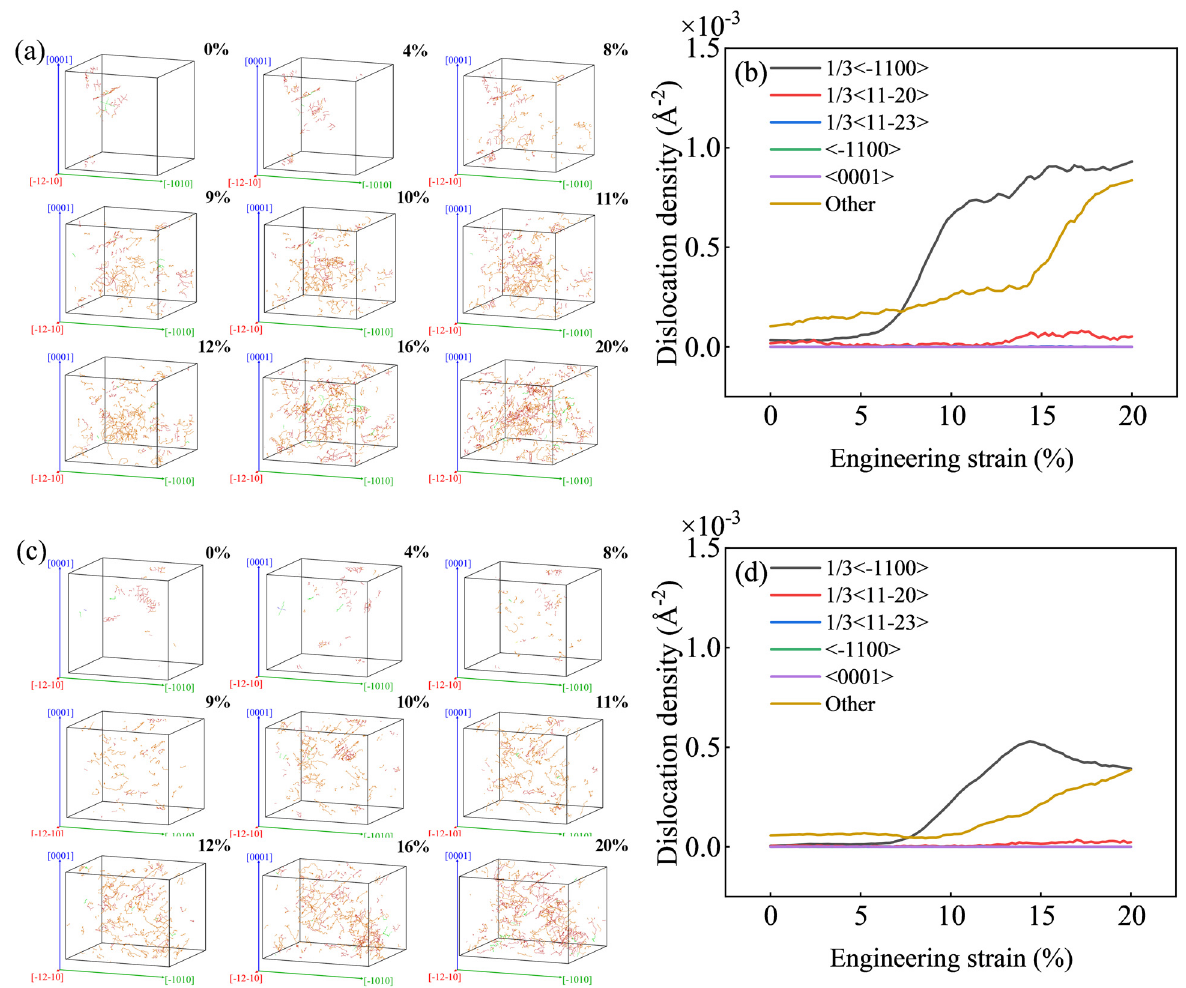
Figure 8: Dislocation evolution: ( a ) dislocation evolution diagram under PSC, ( b ) dislocation evolution diagram under UC, ( c ) dislocation density curve under PSC, and ( d ) dislocation density curve under UC.